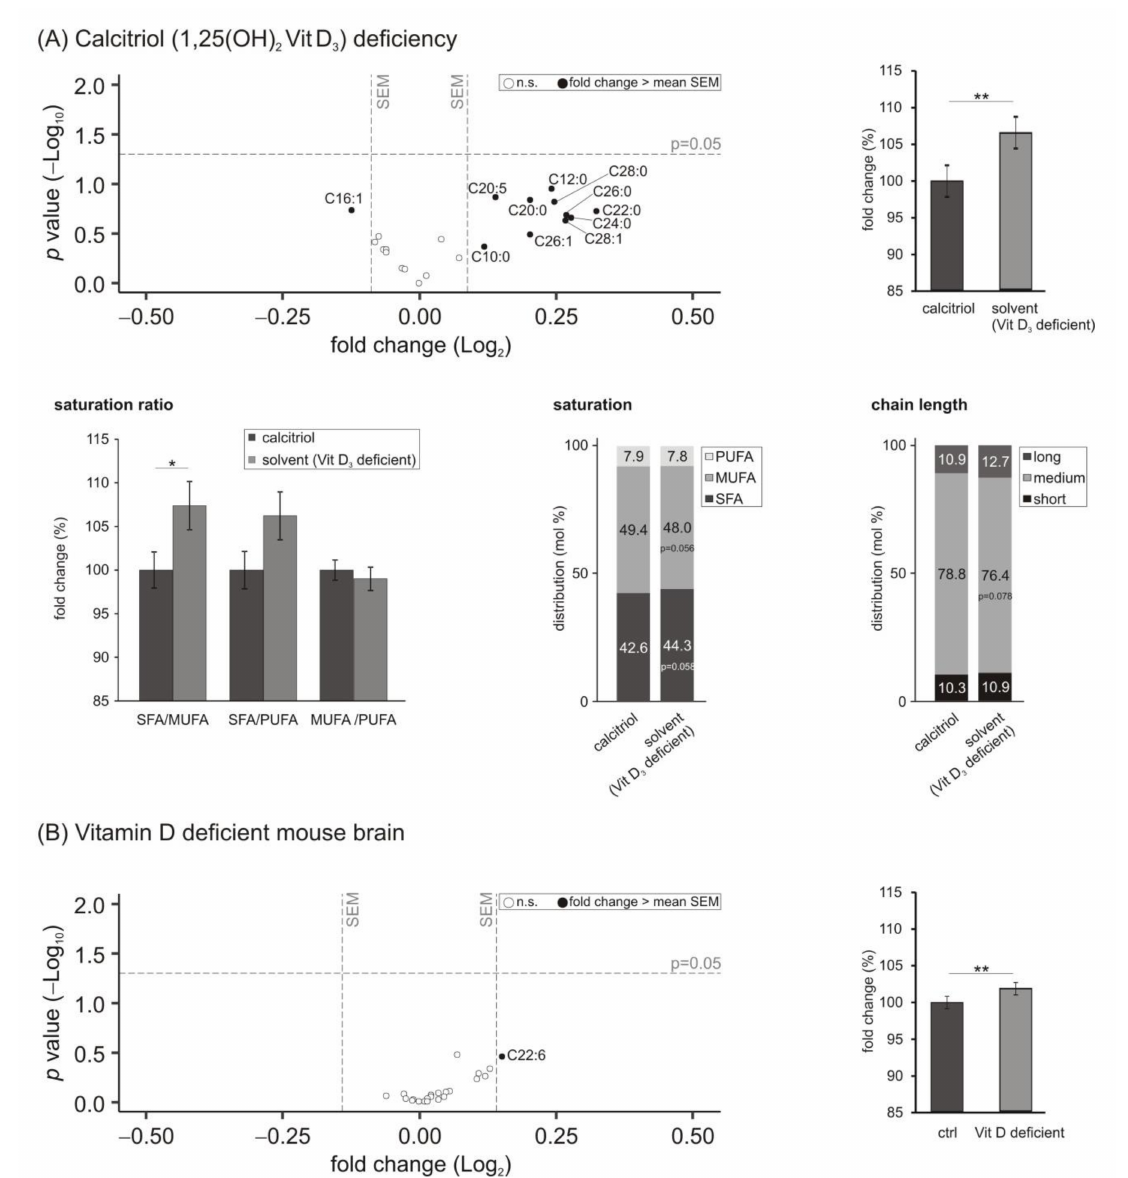
Figure 3. Effect of vitamin D 3 deficiency on lyso phosphatidylcholine (lyso-PC) species. ( A ) The levels of lyso-PC in SH-SY5Y wt cells incubated with the solvent control (ethanol) were compared to cells treated with 1,25-dihydroxy vitamin D 3 . In the volcano plot the fold change ( x -axis) of each of the 22 analyzed lyso-PC species (dots) was plotted against the corresponding p -value ( y -axis). The volcano plots are structured as described in detail in the legend of Figure 1. The bar chart on the right shows the relative fold change of all measured lyso-PC species comparing calcitriol-treated with solvent-control-treated SH-SY5Y cells. Below the volcano plot, ratios dealing with the saturation state of the fatty acids within the lyso-PC species and the distribution of chain length in mol% are shown. ( B ) Analyzed lyso-PC species in brain samples of vitamin D deficient mice compared to control-fed mice in a volcano plot and relative fold changes of all measured lyso-PC species in a bar chart. Error bars represent the standard error of the mean (SEM). Statistical significance was set as * p ≤ 0.05 and ** p ≤ 0.01; n.s. not